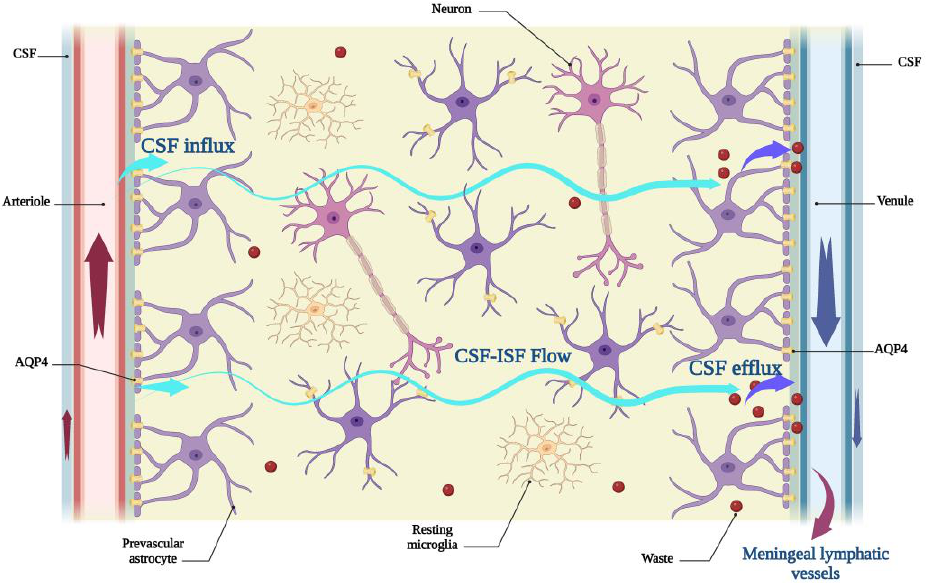
Figure 1. The components of the glymphatic pathway. In the region of Virchow-Robin spaces, CSF along with penetrating arterioles flow into the brain parenchyma. Arterial pulsation provides influx of CSF into the periarterial interstitial space. The system eliminates most neurotoxic agents and waste substances from ISF. AQP4 water channels that are localized in perivascular astrocyte end-feet mediate fluid movements throughout the system. AQP4: aquaporin 4; CSF: cerebrospinal fluid; ISF: interstitial fluid. Created with